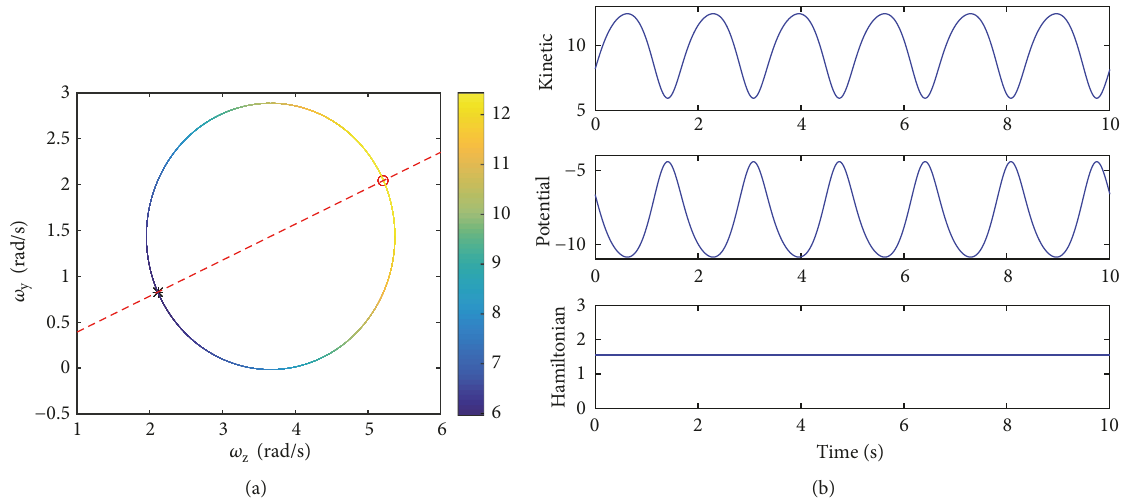
Figure 2: System governed by inertial and internal torques: (a) a periodic orbit with a kinetic energy cycle, (b) kinetic, potential, and Hamiltonian